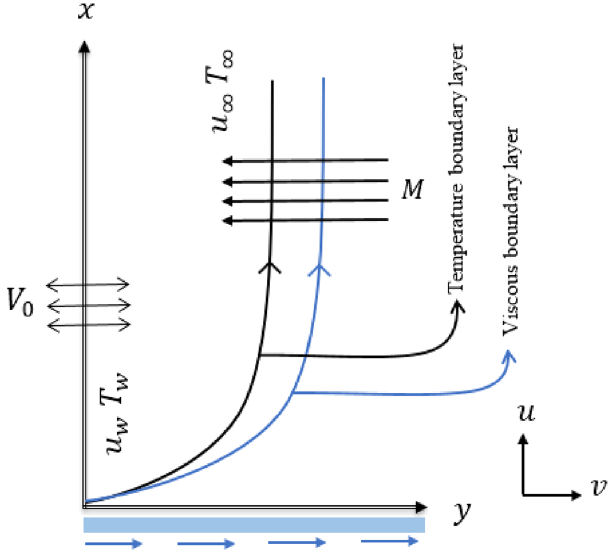
Figure 1. Flow model